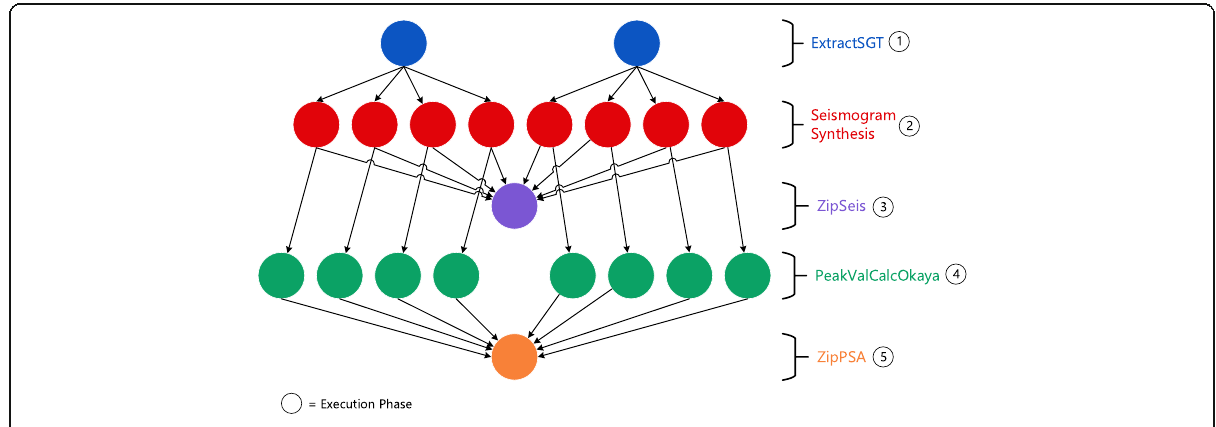
Fig. 3 DAG of a sample CyberShake application (based on